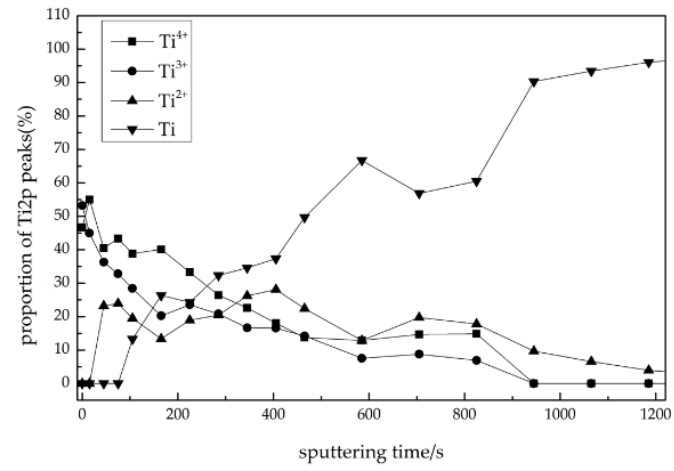
Figure 4. XPS sputtering analysis of TiO x surface to further analyze the change of Ti ions at the valence bonds and the content in the deeper oxide layer. The contents of TiO x and Ti were both almost 50% at 50 nm, which indicated that the thickness of the oxide coating was about 50 nm.